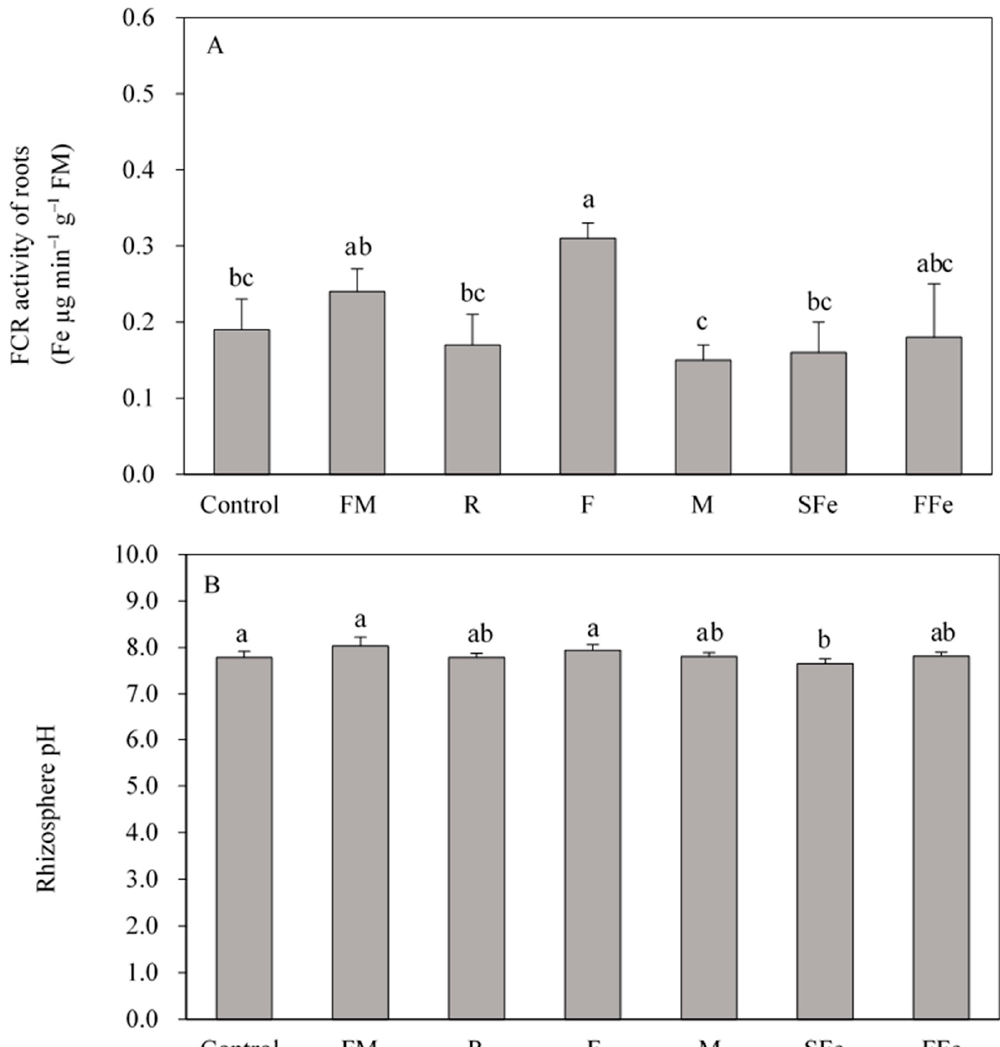
Figure 5. Ferric-chelate reductase (FCR) activity of roots ( A ) and rhizosphere pH ( B ) of HG-QA grown in different practices. HG-QA: “Huangguan” pear grafted onto quince A. Control: ridging with landscape fabric mulching and without other treatments; FM: flattening with landscape fabric mulching, R: ridging without landscape fabric mulching; F: flattening without landscape fabric mulching; M: Manure application; SFe: Fe application in soil; FFe: Foliar Fe application. The different letters mean statistical differences between treatments, p < 0.05 (Benjamini–Hochberg correction).